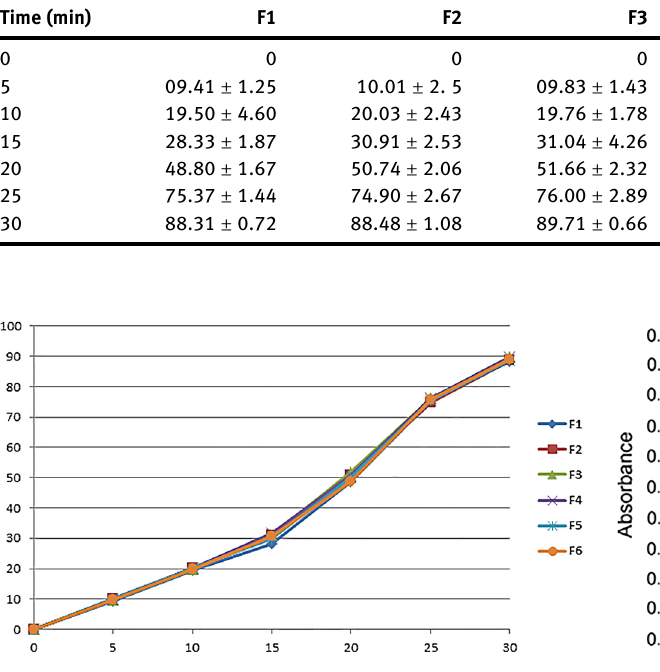
Figure 1: In-vitro drug release pro fi le of different formulations.